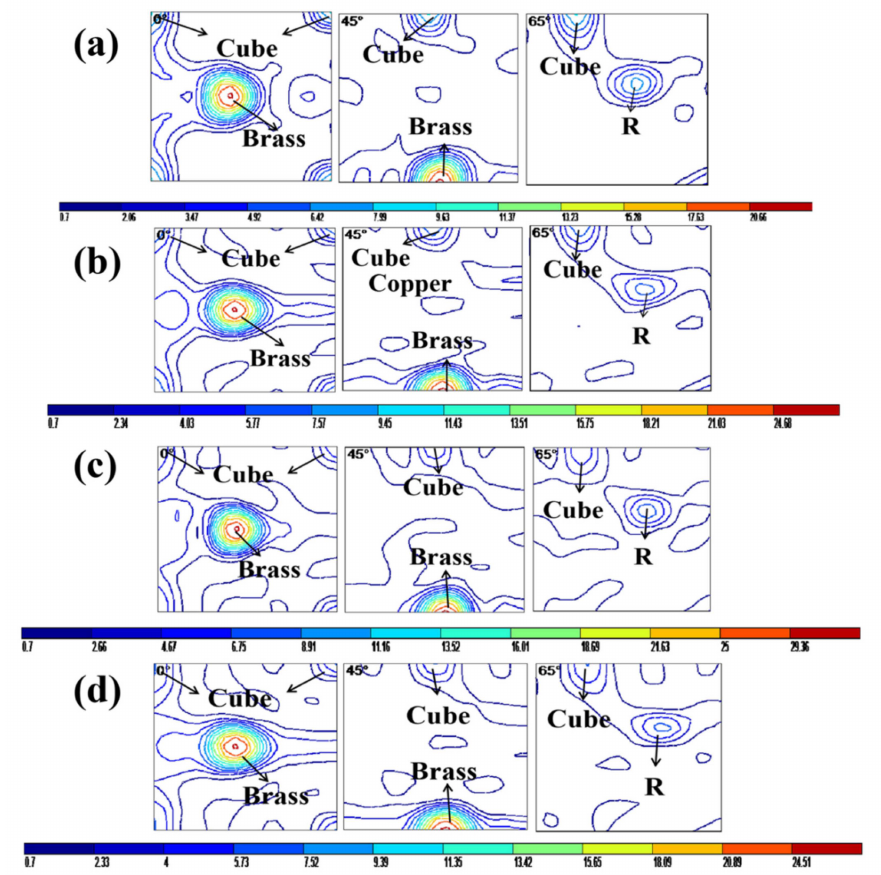
Figure 7. ODF results of 65 mm hot rolled plates after solution at 477 ◦ C for: ( a ) 30 min, ( b ) 90 min, ( c ) 210 min, ( d ) 330